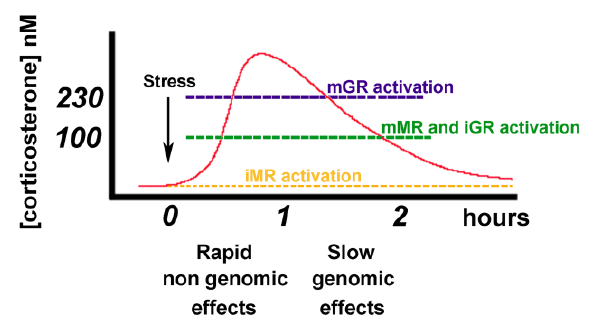
FIGURE 1. Time course of MR and GR activation following stressful stimuli. At a resting level, iMR are already saturated by the baseline levels of corticosterone. Rising concentration of corticosterone activates both mMR and iGR, whereas an additional increase in corticosterone levels also activates mGR. mMR- and mGR-mediated effects appear in a faster time course than those mediated by the intracellular receptors. Adapted from de Kloet et